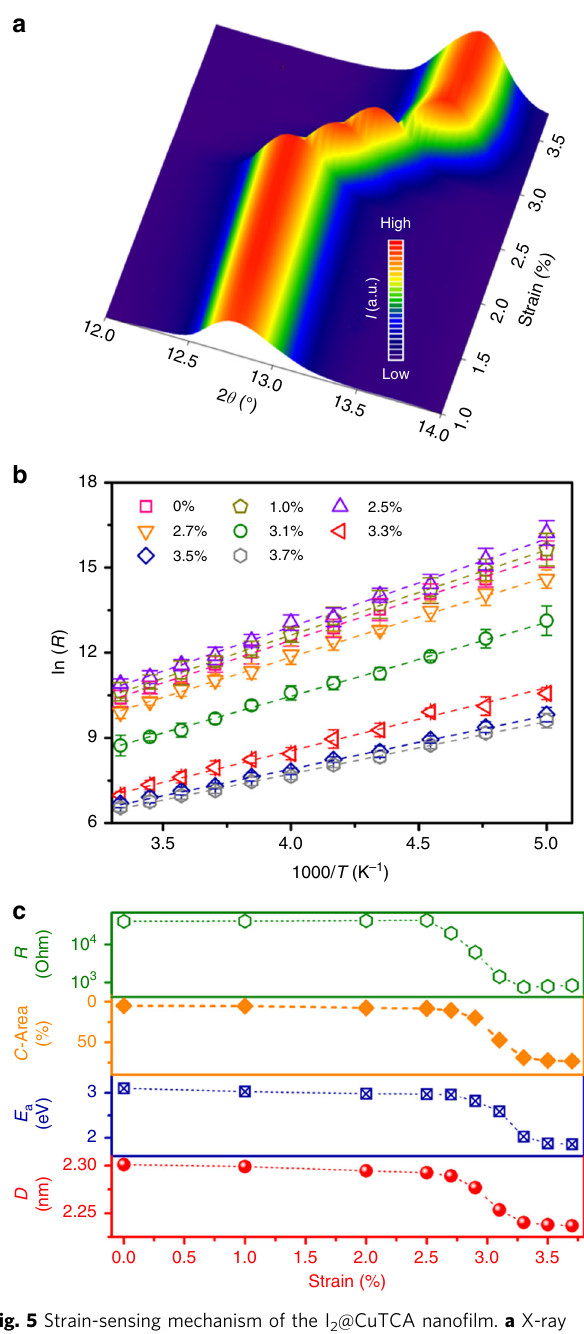
Fig. 5 Strain-sensing mechanism of the I 2 @CuTCA nano fi lm. a X-ray diffraction pattern of the I 2 @CuTCA nano fi lm under bending strains of 1.0% to 3.5%. b Resistance-temperature characteritics of the MOF sensor under different bending strains. c Resistance – strain ( R – S ), conductive area – strain ( C – Area – S ), activation energy – strain ( E a – S ) and 111-direction crystalline interplane spacing-strain ( D – S ) relationships of the I 2 @CuTCA nano fi strain of the fi lm before the appearance of non-elastic deforma- tion and/or cracking. As such, the geometrical and electronic structure of the I 2 @CuTCA particulates stops to evolve (Fig. 5a) and the total conductive area of the MOF nano fi lm stabilizes (Supplementary Figure 10), corresponding to the macroscopic device current saturation at the same strain level.